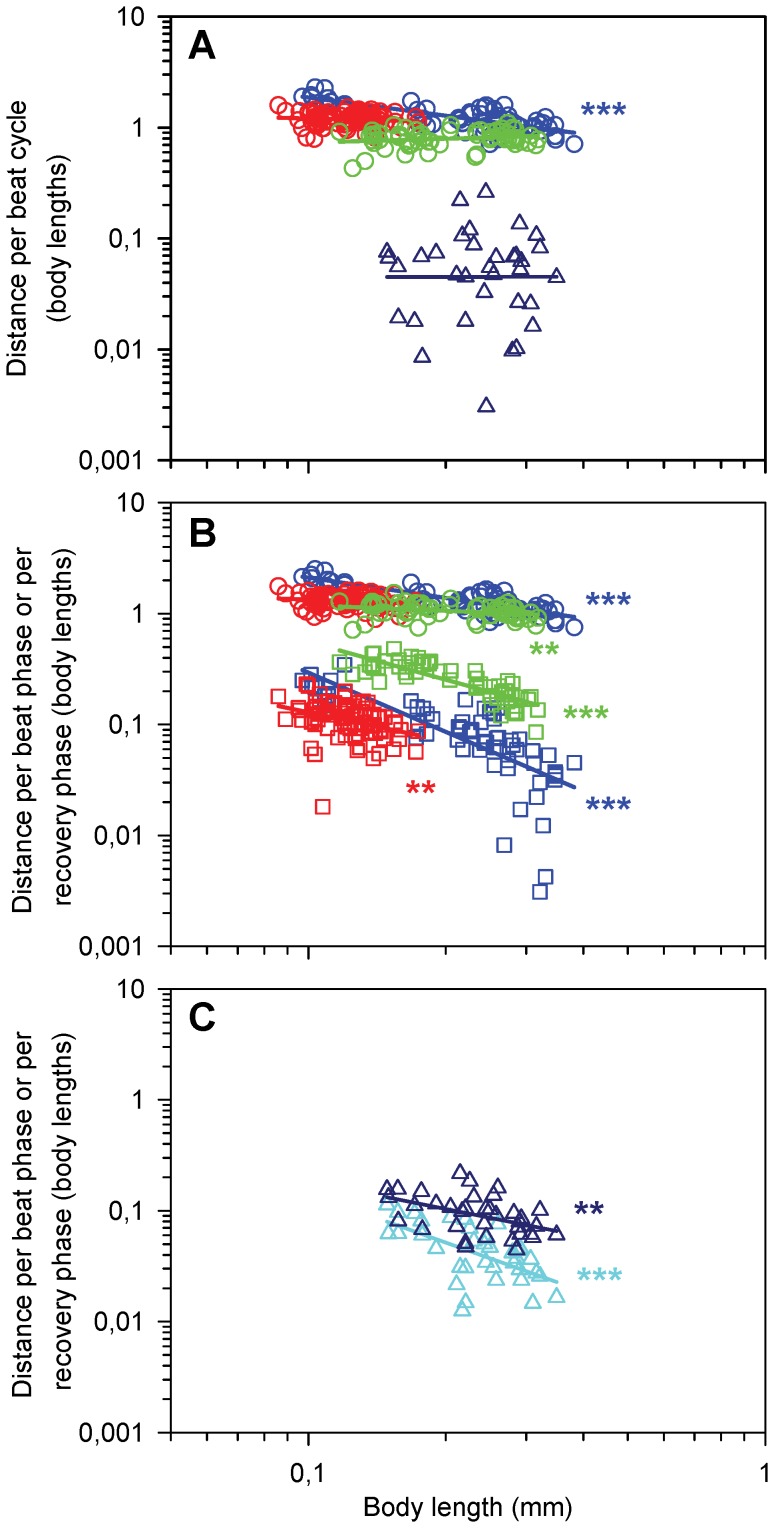
Distance travelled per beat as function of body length (BL) in nauplii.Regression lines are power laws fitted to the data. A) Body length specific net distance per beat cycle (DBC). Blue circles, T. longicornis: Log(DBC) = −0.54Log(BL) –0.27 (r2 = 0.58, p<0.0001, n = 63); red circles, O. davisae (slope  = −0.07, p = 0.29, n = 82); green circles, A. tonsa (slope  = 0.12, p = 0.25, n = 59); blue triangles, swimming T. longicornis (slope  = 0.01, p = 0.94, n = 36), B) Body length specific distances for the beat (DBP) and recovery (DRP) phases. Blue circles, T. longicornis beat phase (slope  = −0.61, r2 = 0.70, p<0.0001, n = 63); blue squares, T. longicornis recovery phase (slope  = −1.77, r2 = 0.54, p<0.0001, n = 63); red circles, O. davisae beat phase (slope  = −0.16, r2 = 0.03, p = 0.08, n = 81); red squares, O. davisae recovery phase (slope  = −0.86, r2 = 0.11, p = 0.001, n = 81); green circles, A. tonsa beat phase (slope  = −0.17, r2 = 0.09, p = 0.006, n = 59); green squares, A. tonsa recovery phase (slope  = −1.14, r2 = 0.70, p<0.0001, n = 58), C) Swimming T. longicornis, body length specific distances for the beat (DBP) and recovery phases (DRP). Blue triangles, beat phase: Log(DBP)  = −0.82Log(BL) –1.56 (r2 = 0.22, n = 36, p = 0.005); cyan triangles, recovery phase: Log(DRP)  = −1.47Log(BL) –2.32 (r2 = 0.36, n = 36, p<0.0001).